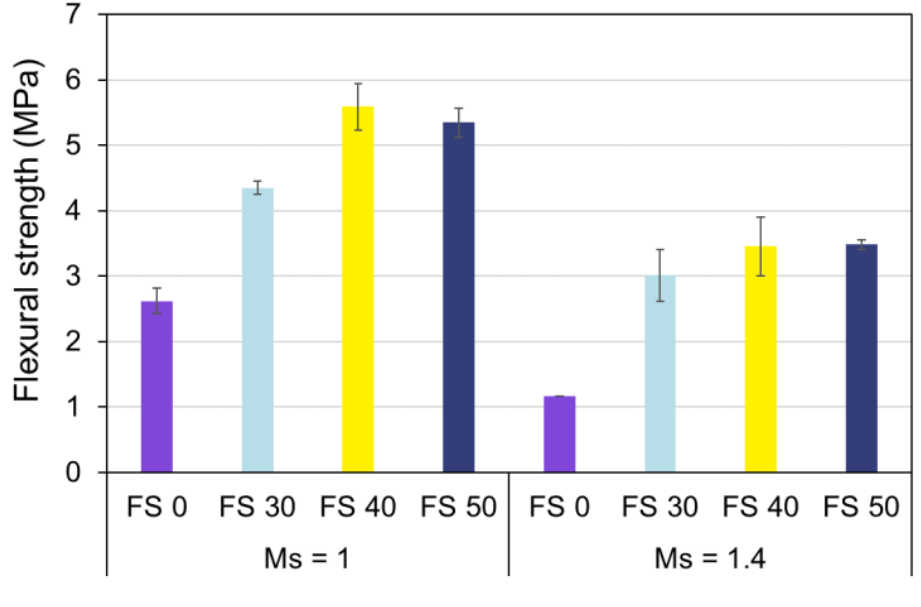
Figure 26. Flexural strength of AAC.